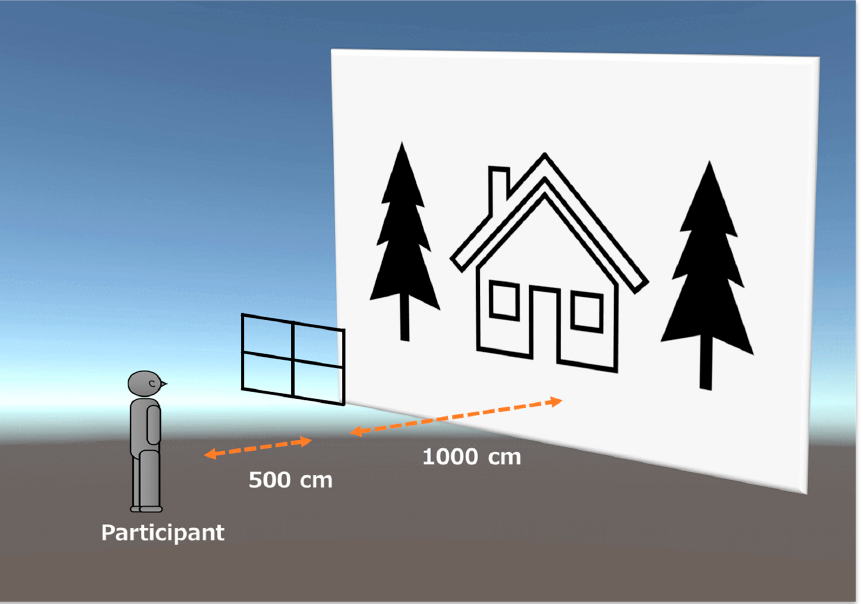
Figure 1. Illustration showing the experimental setup of virtual reality. The visual background consisted of a house with a garden placed 1500 cm away from the participant. The participant was asked to gaze at a cross placed at the center of the window frame set 500 cm away from them.